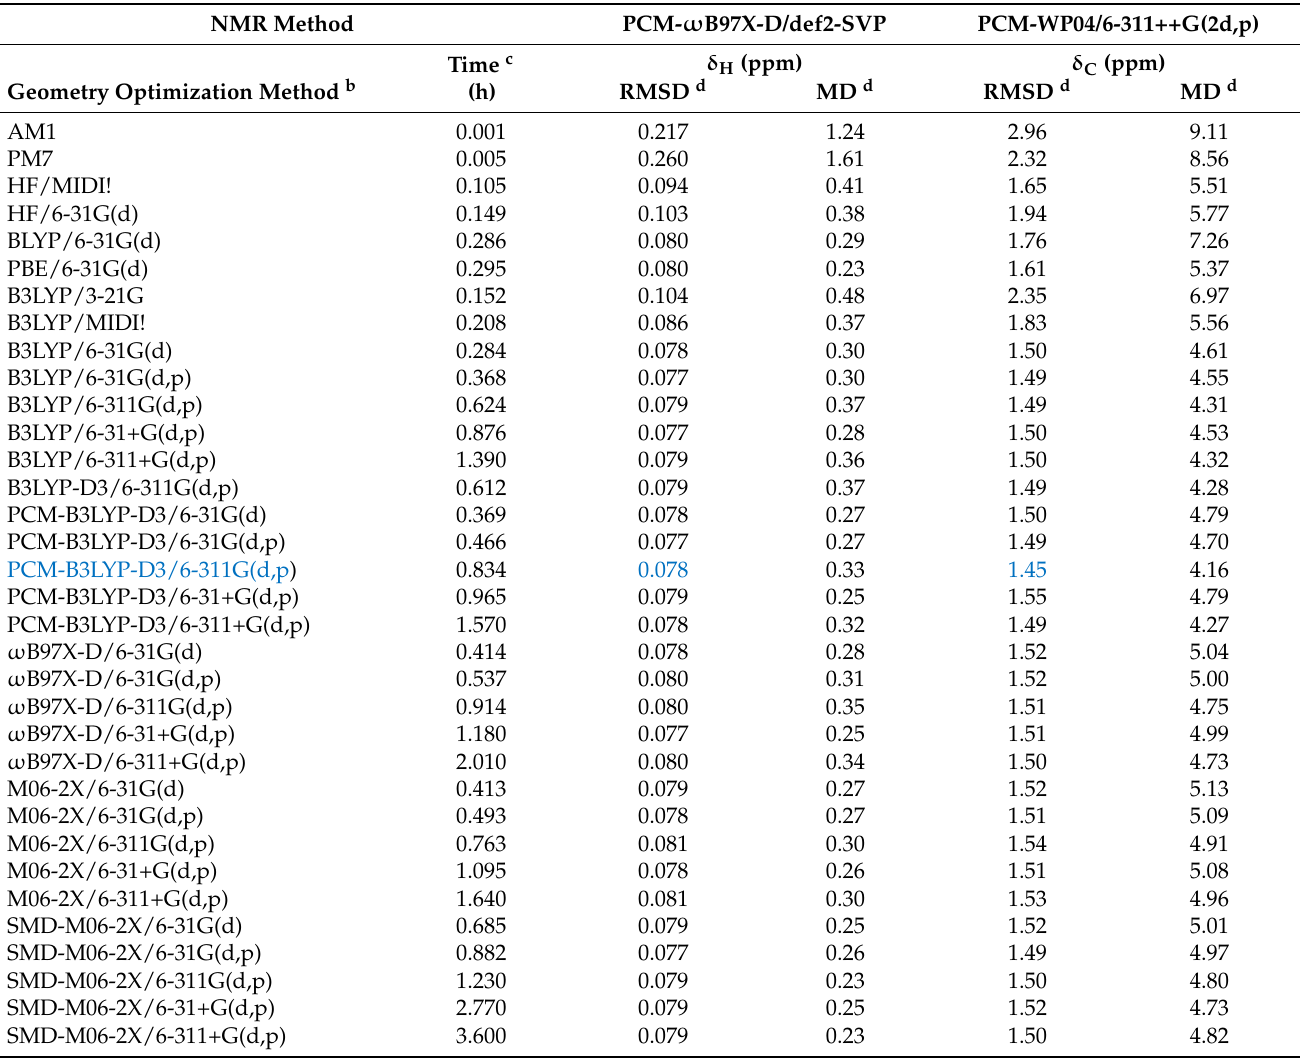
Table 5. Impact of molecular geometry on chemical shift predictions a .